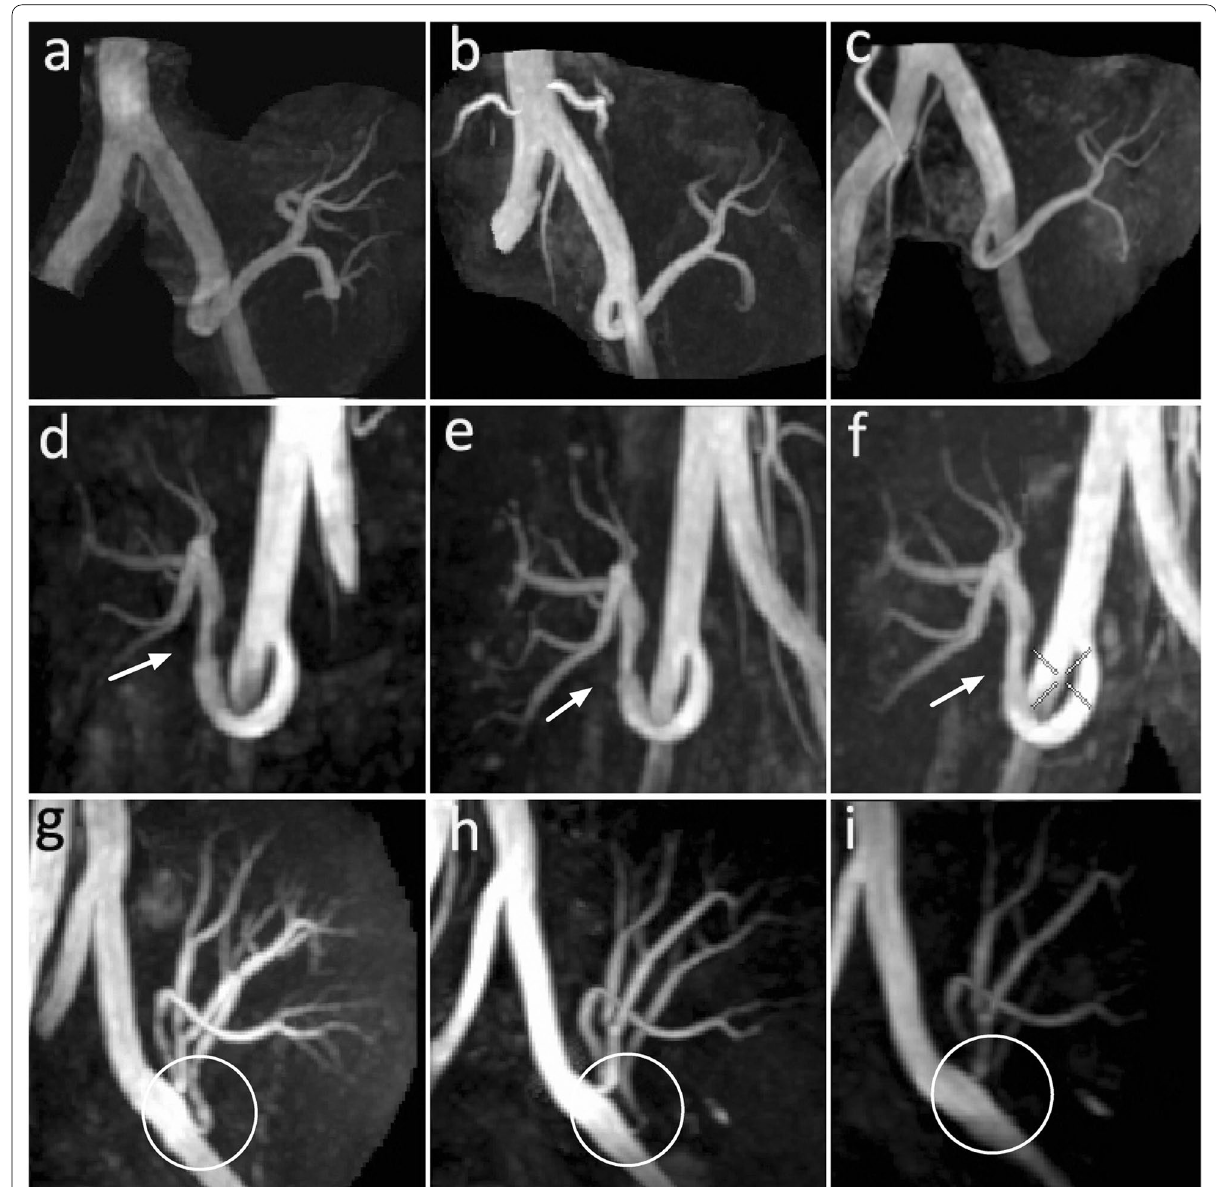
Fig. 4 Three IFIR examinations were performed in three patients. a, b, c A 49-year-old patient had 3 IFIR examinations on 2017-7-6, 2017-11-12, and 2018-6-4, respectively; d , e , f a 39-year-old patient had 3 IFIR examinations on 2016-4-26, 2016-5-17, and 2016-6-21, respectively; g , h , i A 32-year-old patient had 3 IFIR examinations on 2016-6-30, 2016-8-2, and 2016-8-22, respectively, and an accessory renal artery was seen clearly in g